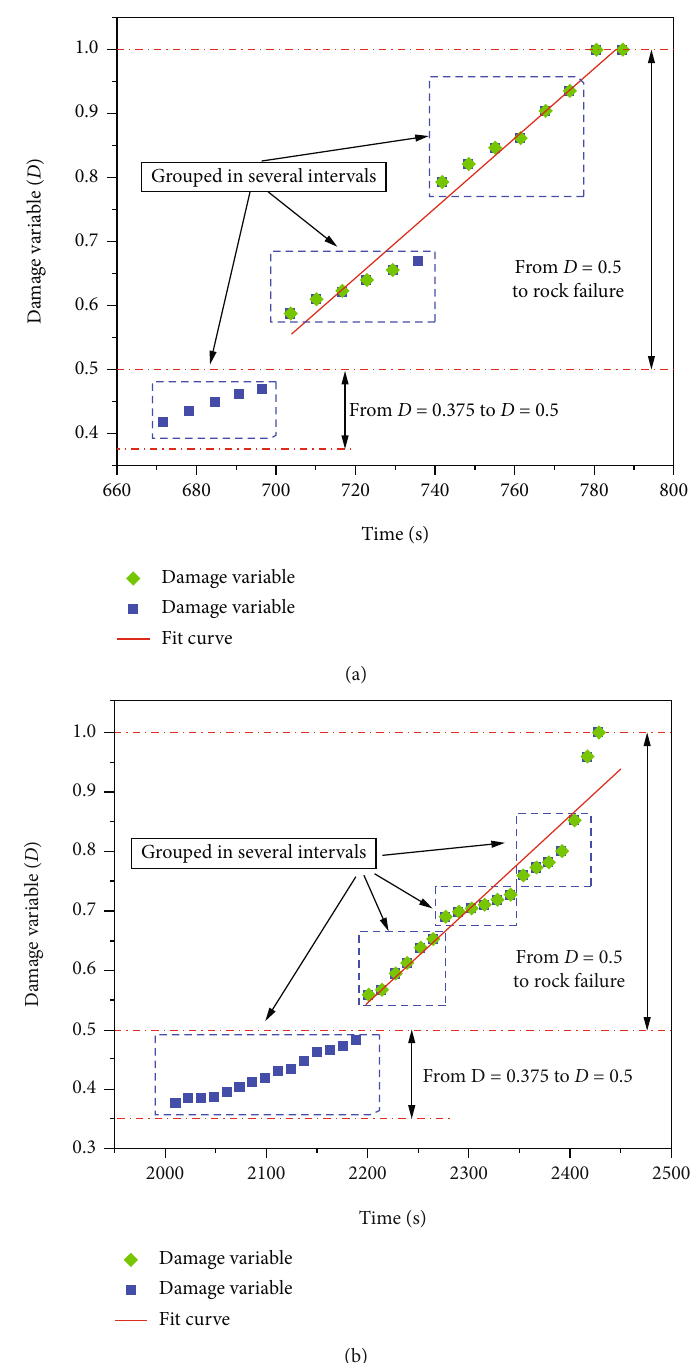
Figure 6: The damage evolution characteristic from D = 0 : 375 and D = 0 : 5 to rock failure. (a) The result of specimen R1. (b) The result of specimen